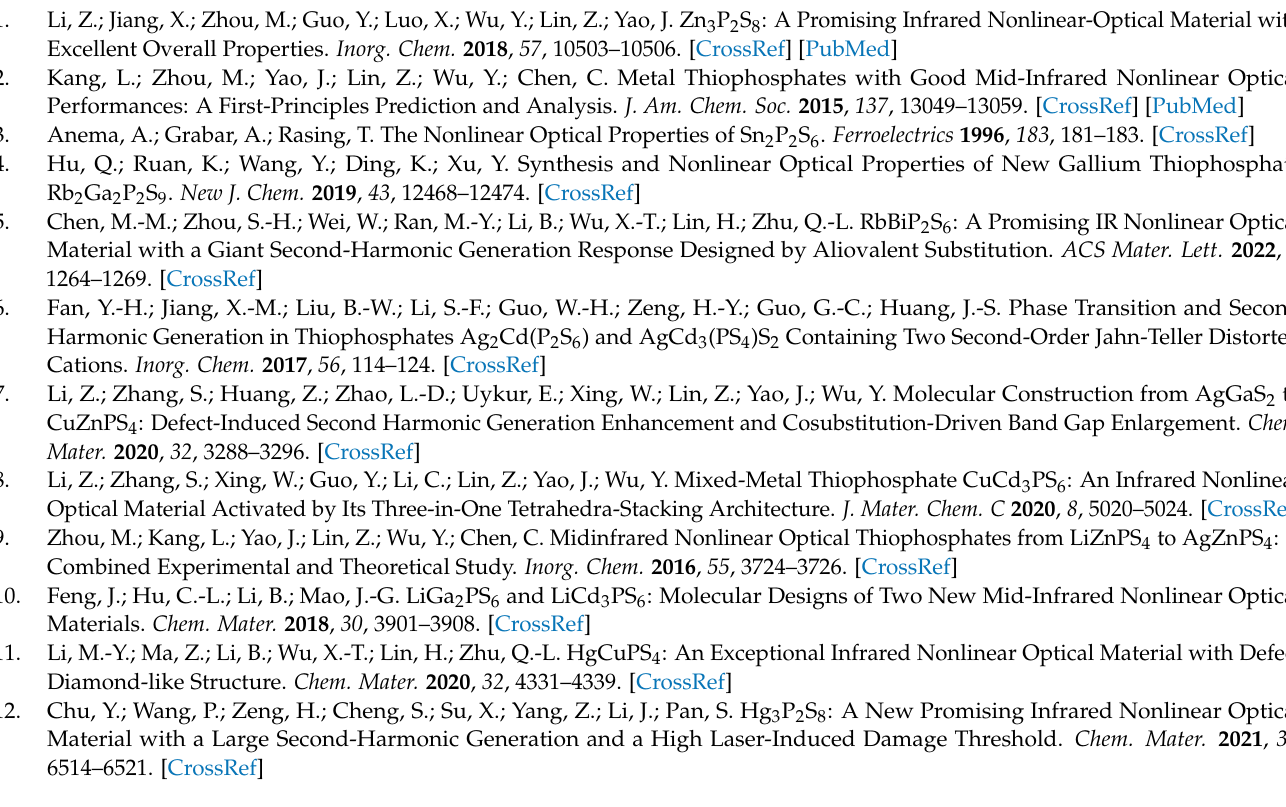
data (Figure S1), ELF calculation (Figure S2), UV-Vis data (Figure S3), Tauc plots (Figure S4), SHG measurements (Figure S5), LDT measurement results (Table